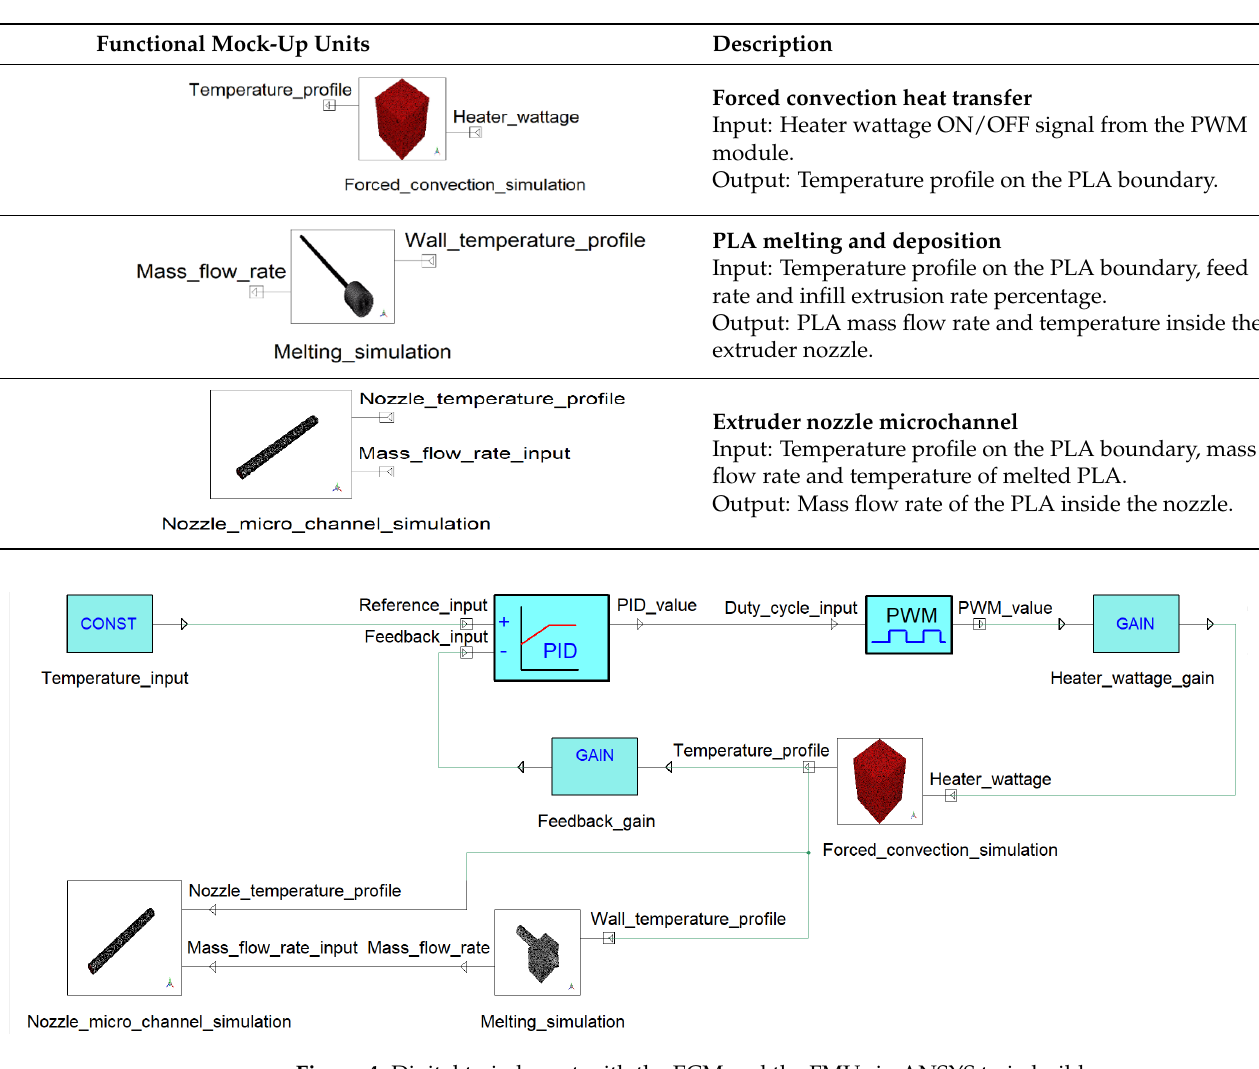
Figure 4. Digital twin layout with the ECM and the FMUs in ANSYS twin builder.